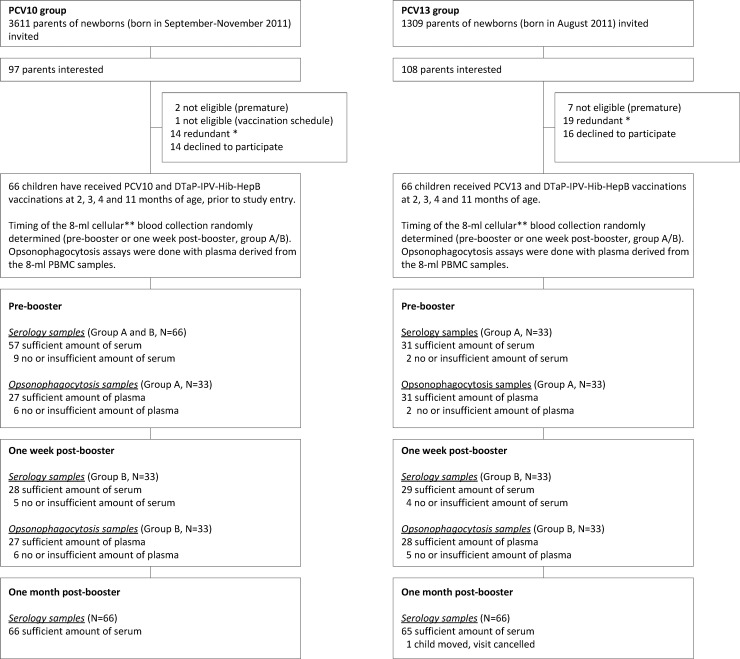
Enrollment and Study Participation.PCV10 indicates 10-valent pneumococcal conjugate vaccine, Synflorix; PCV13 indicates 13-valent pneumococcal conjugate vaccine, Prevenar-13. * When the enrolment target was reached, further children were considered redundant, and their parents’ informed consent procedures were cancelled. ** Plasma cell and memory B-cell analysis published by van Westen et al.[27].